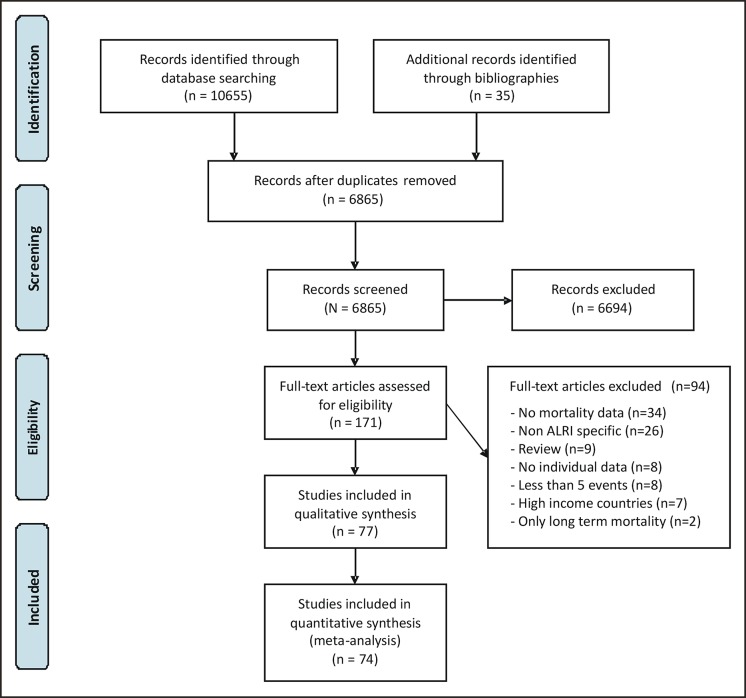
Flow chart for bibliographic search.